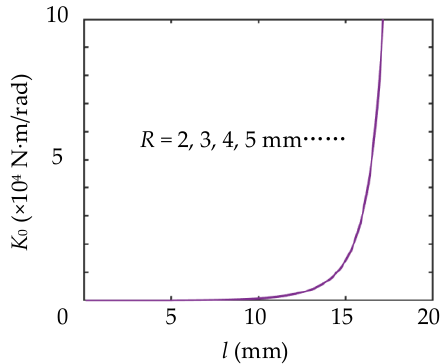
Figure 10. Stiffness curves near the initial state at different values of L 0 .